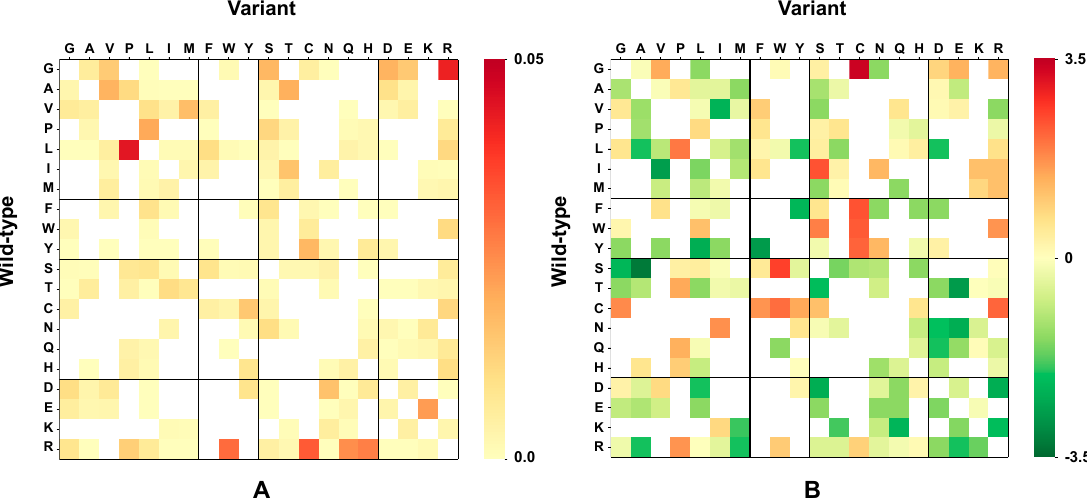
Figure 1. Disease-related variation types in HVAR3D. ( A ) The heatmap shows the frequency of occurrence of each variation type in the set of the disease-related variants. The color spans from yellow (low frequency) to red (high frequency); ( B ) The heatmap shows the association strength of each variation type to disease (Log-odd among frequencies of each variation type of the disease and neutral sets). Residues are grouped as follows: apolar (GAVPLIM), aromatic (FWY), polar (STCNQH), charged (DEKR), with residues in the same group listed at increasing order of size. The color code spans from green (variant types most frequent in the neutral set) to red (variant type most frequent in the disease related type). Computational methods are detailed in Materials and Methods.